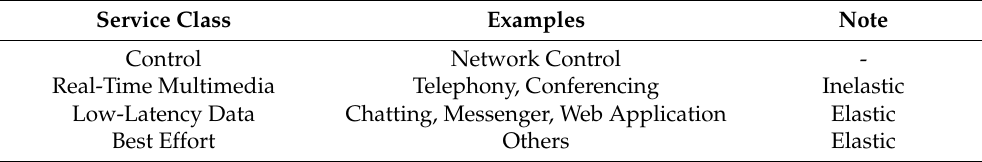
Table 1. Service classes.